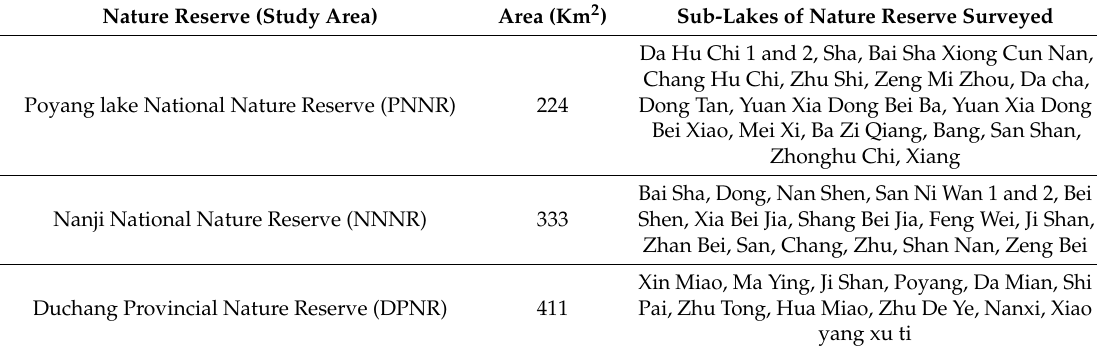
Figure 1. Location of the study area. Sub-section of Poyang Lake, Jiangxi Province, China. Table 1. List of sub-lakes surveyed.